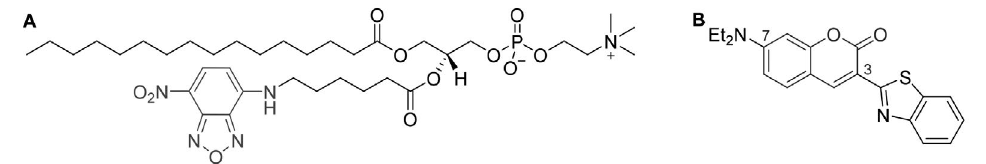
Figure 1. (A) Structure of the phospholipid analog C6-NBD-PC , N -(7-nitrobenz-2-oxa-1,3-diazol-4-yl (NBD) is in green. (B) Coumarin 6 dye with coumarin scaffold highlighted in blue and with marked positions 3 and